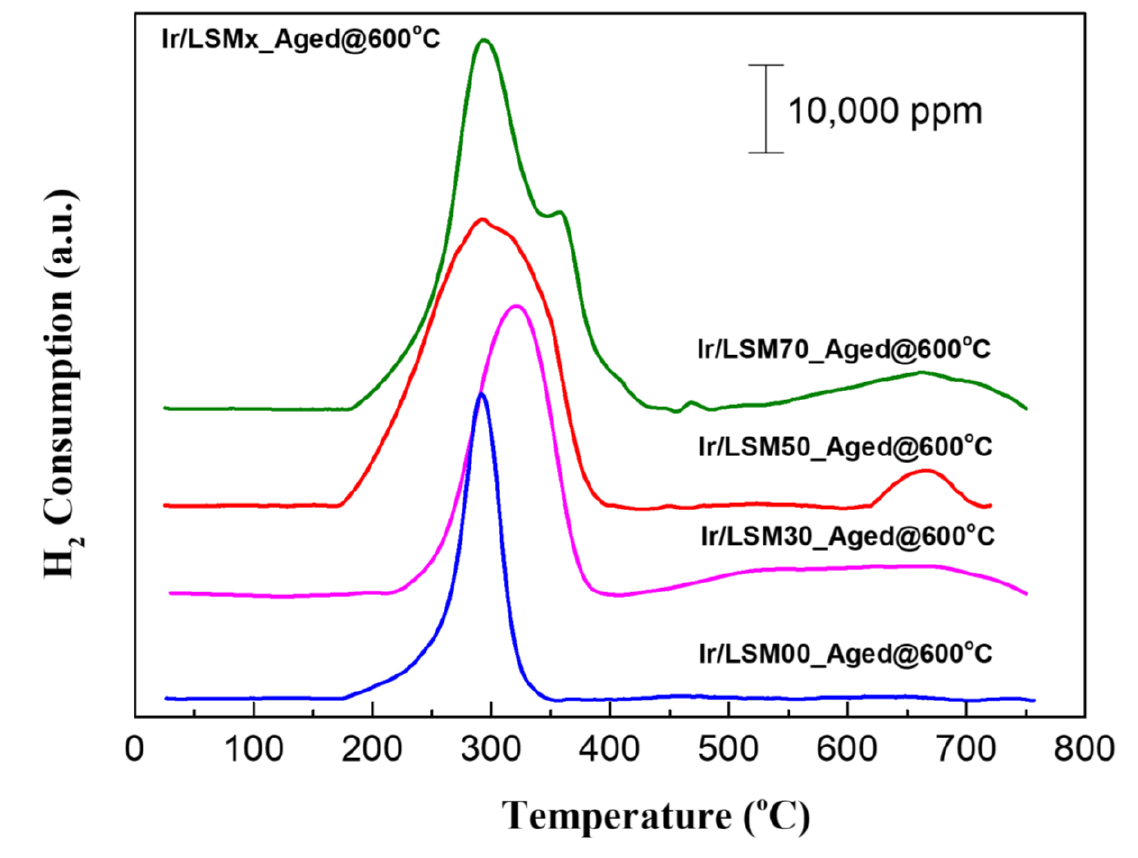
Figure 9. H 2 -TPR profiles of the Ir/LSMx catalysts thermally aged at 600 ◦ C for 5 h in air. Table 2. Total surface area (S BET ) and Ir nanoparticles’ average size and dispersion of Ir/LSMx catalysts aged at 600 ◦ C for 5 h in a 20% O 2 /He flow.